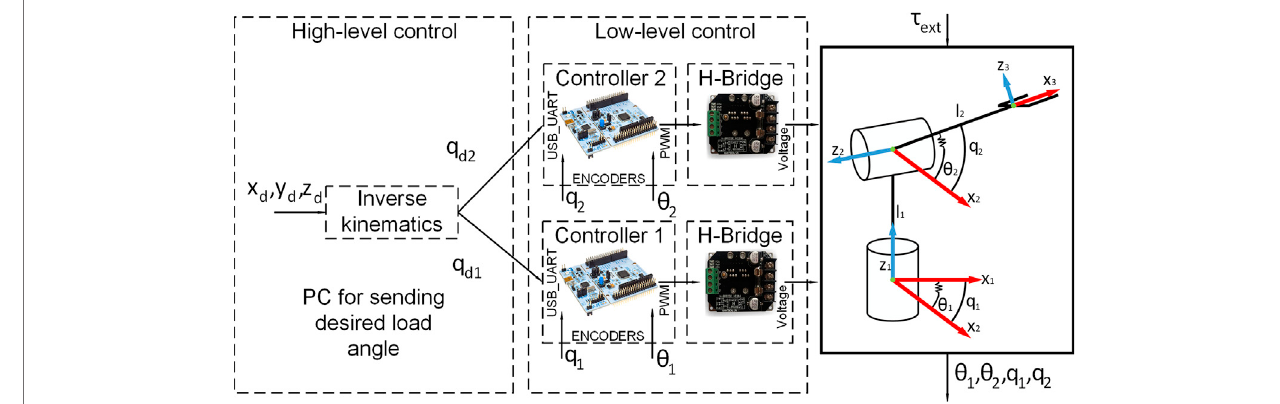
FIGURE 9 | Software design.